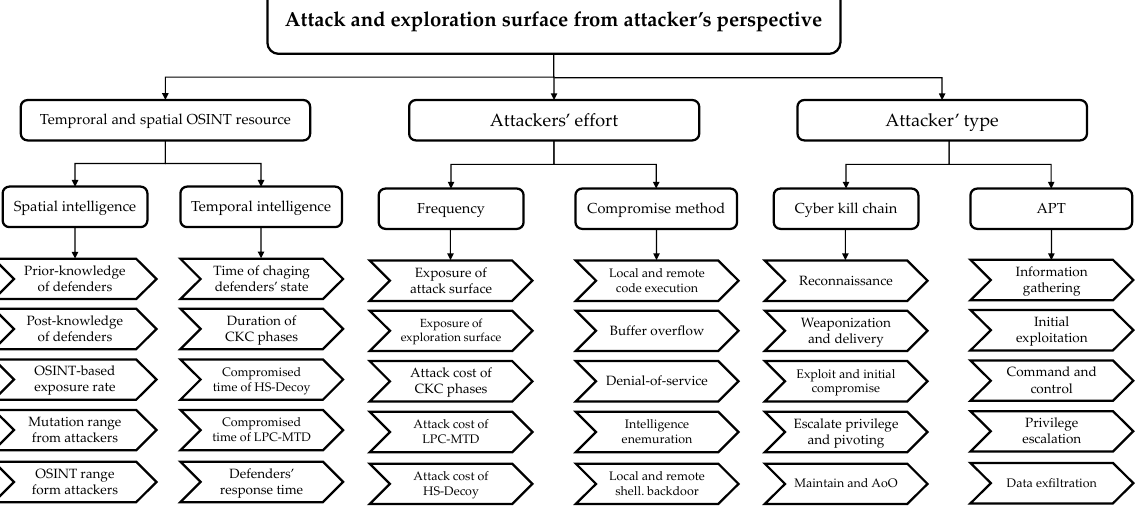
Figure A3. Hierarchical compound metric tree based on attackers’ perspective.